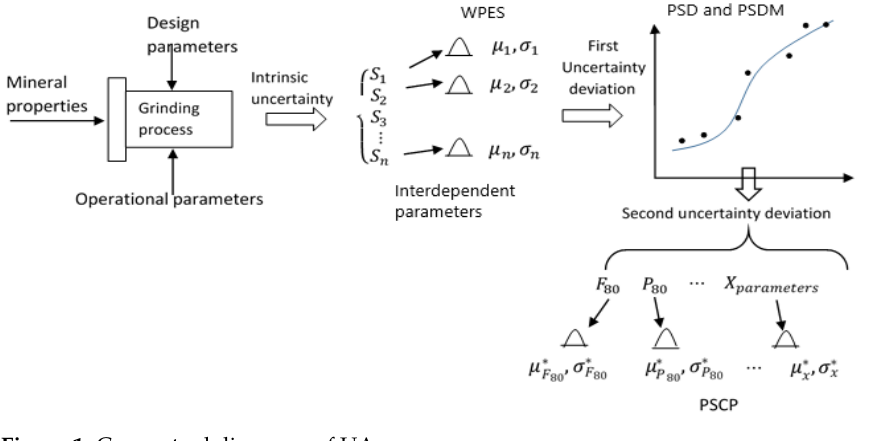
Figure 1. Conceptual diagrams of UA.